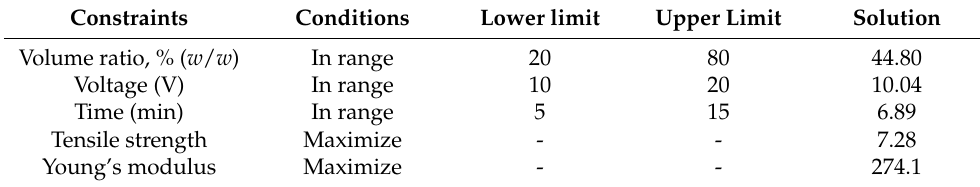
Table 14. Constraints for optimization for 20% and 80% experimental water design. Constraints Conditions Lower